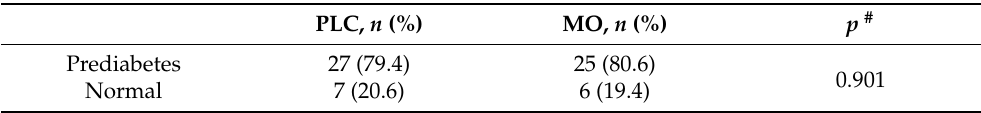
p # , Comparison between treatment groups by Chi-square test.